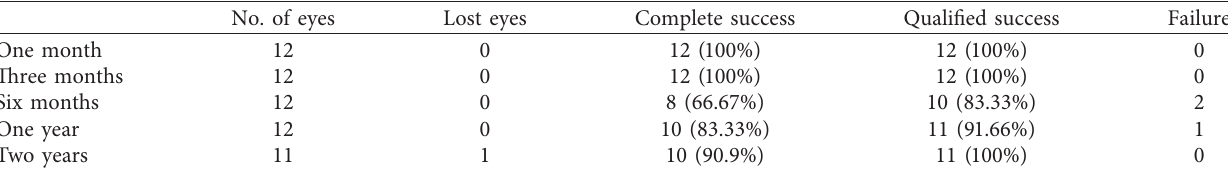
Table 4: Success and failure rates over time.